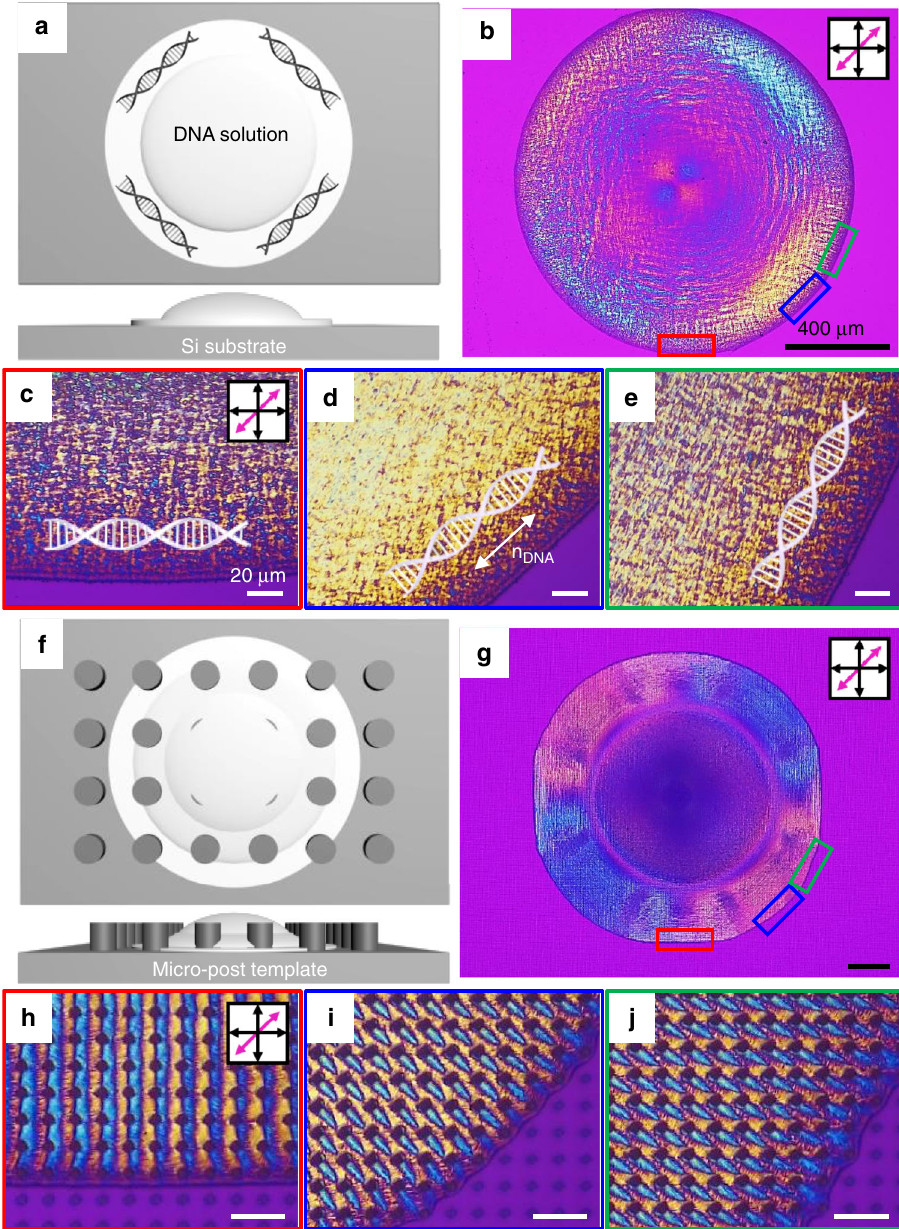
Fig. 1 Fabrication scheme and POM images of DNA fi lms on a fl at/micropost-patterned substrate. a Simply dried DNA fi lm on the fl at Si substrate and b its POM image. c – e Enlarged images from b show distinctive colours depending on the position of the DNA fi lm, and the corresponding orientation of DNA chains. f Hydrated DNA fi lm on the microposts and g its POM image. h – j Enlarged images from g show the different patterned textures depending on the drying direction. Black scale bars represent 400 μ m and white ones are 20 μ